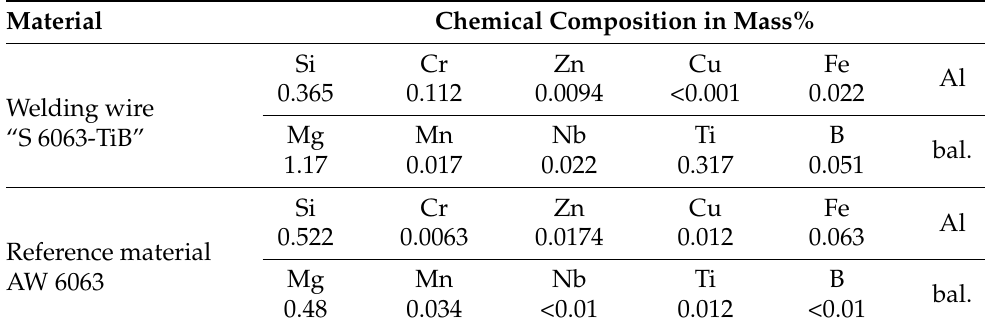
Table 1. Chemical composition of welding wire and reference material.